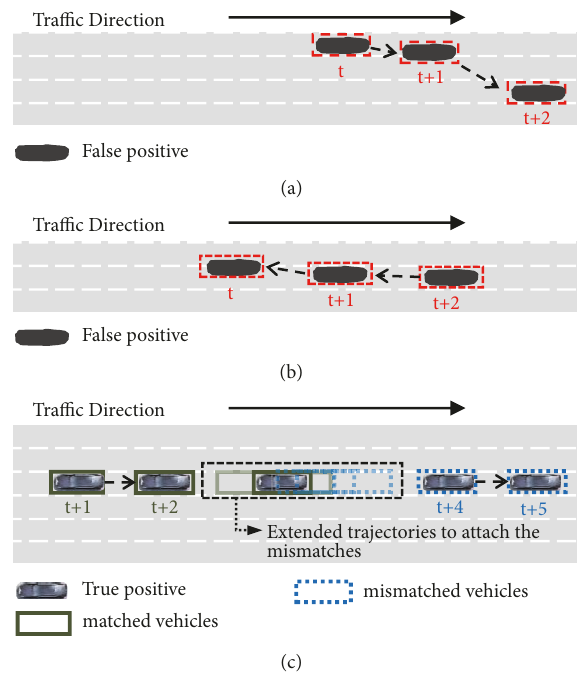
Figure 3: False tracks generated in congested traffic: (a) excessive lateral movement, (b) reverse direction, and (c)